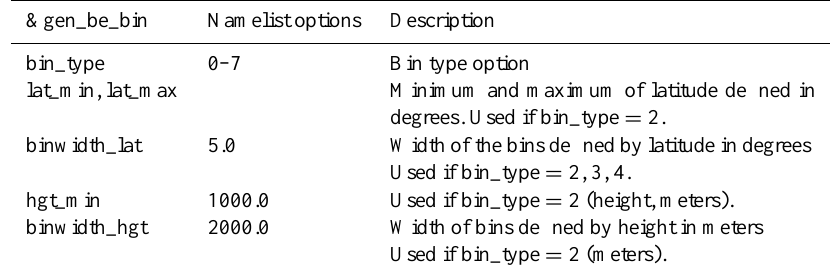
Table B3. Parameters defining the binning options of the namelist input file (&gen_be_bin